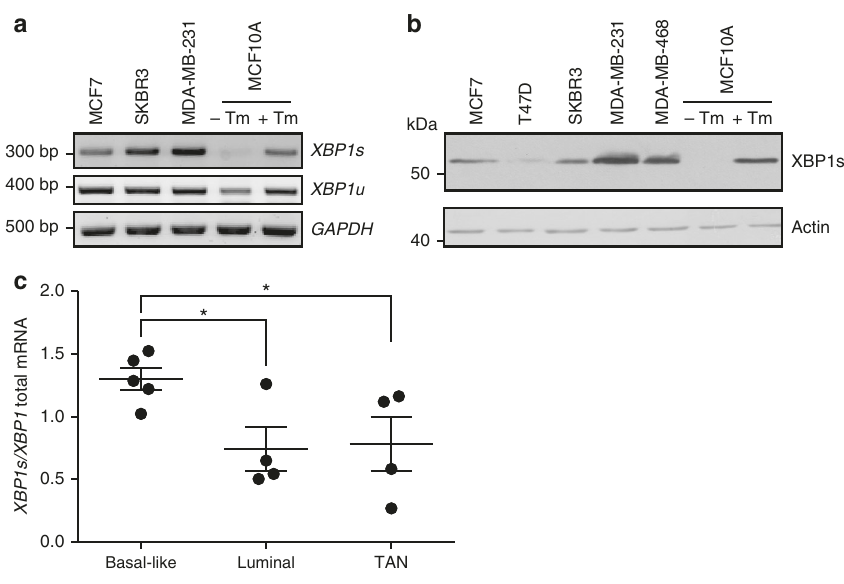
Fig. 1 Breast cancer cells exhibit constitutive IRE1 RNase activity. a Expression of spliced and unspliced XBP1 mRNA was assessed in a panel of breast cancer cell lines (MCF7, SKBR3, MDA-MB-231) and the non-tumorigenic breast epithelial cell line MCF10A via RT-PCR. Tunicamycin (Tm) (1 μ g ml − 1 )- treated MCF10A cells act as a positive control for XBP1 splicing. GAPDH was used as a loading control. b Immunoblotting of XBP1s in a panel of breast cancer cell lines (MCF7, T47D, SKBR3, MDA-MB-231, and MDA-MB-468) and the non-tumorigenic breast epithelial cell line MCF10A. Tm (1 μ g ml − 1 )- treated MCF10A cells act as a positive control for XBP1 splicing. Actin was used as a loading control. c Q-PCR quanti fi cation of the relative mRNA levels of spliced to total XBP1 in RNA samples obtained from basal-like tumor tissue ( n = 5), luminal tumor tissue ( n = 4), and tumor-associated normal (TAN) tissue ( n = 4). Results shown for a and b are representative of three independent experiments. * P < 0.05 based on a pairwise single factor ANOVA tests comparing each tissue type. Error bars represent